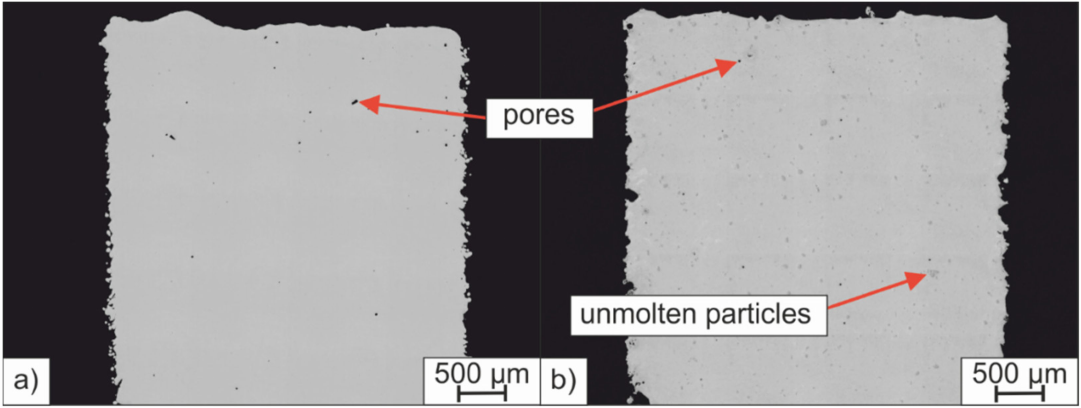
Figure 10. Side-view cross-section of samples manufactured with 160 W laser power and 810 mm/s scanning speed; ( a ) H-PRE, ( b )